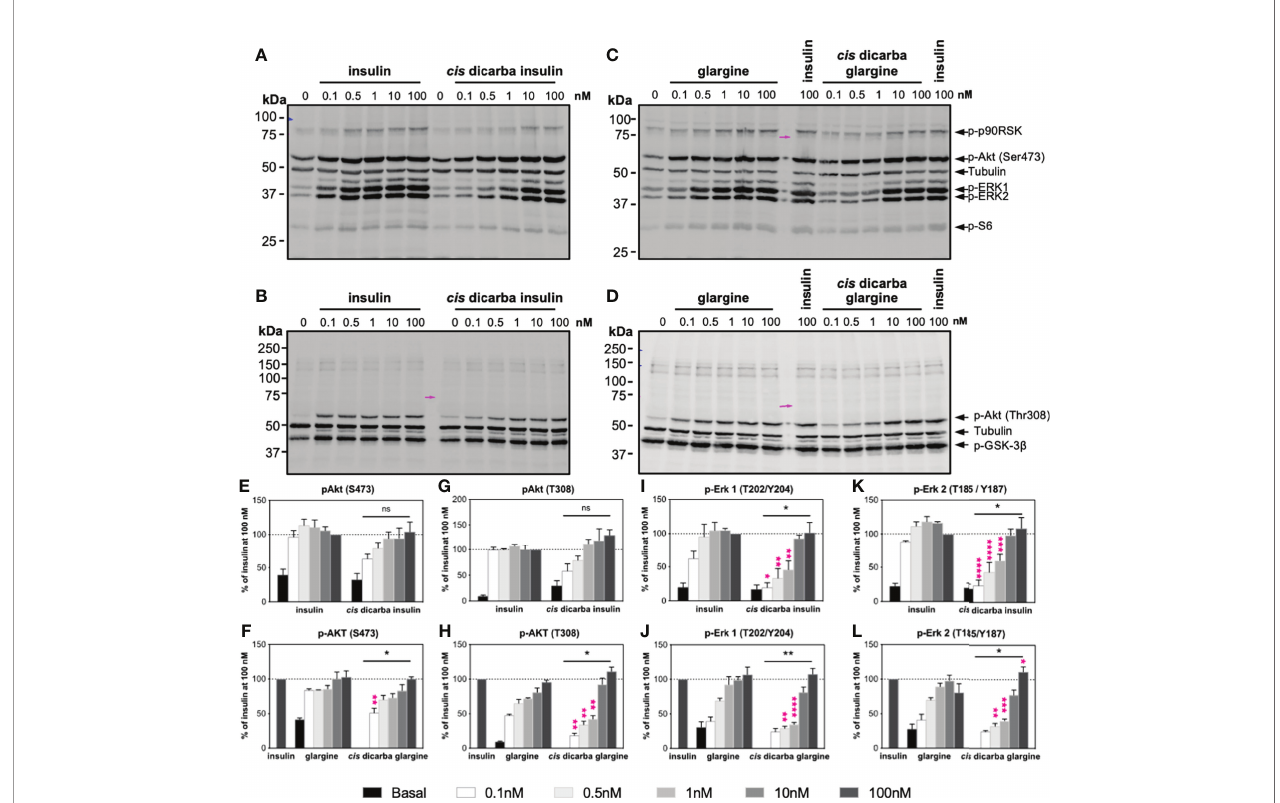
FIGURE 4 | Cis- dicarba insulin and cis- dicarba glargine insulin exhibit dose-dependent signaling bias via IR-A overexpressing cells. Serum starved IR-A overexpressing L6 myoblasts (hIR-A L6) were stimulated for 10 min with increasing concentrations (0, 0.1, 0.5 1, 10 and 100 nM) of (A – B) insulin or cis- dicarba insulin, (C, D) insulin glargine or cis- dicarba glargine. Pink arrow aligns to 75 kDa marker (representative blots of n = at least 3 independent experiments). (E-L) Quantitation of western blots. Phosphorylation levels are expressed as percentage of level detected when cells were stimulated with 100 nM of insulin for 10 min; normalized to b -tubulin: (E, F) Akt (phospho-Ser473), (G, H) Akt (phospho-Thr308), (I, J) ERK 1 (phospho-Thr202/Tyr204) and (K, L) ERK 2 (phospho-Thr185/ Tyr187). Quantitation of other phosphorylated proteins are included in Figure S3 . All data are the mean ± S.E.M . Statistical signi fi cance of the overall difference in phosphorylation levels stimulated by cis- dicarba insulin compared to native insulin or cis- dicarba glargine compared to glargine insulin were determined via 2 -way ANOVA (bars above graph); difference comparing each stimulating concentration (pink asterisks) were further analyzed using Holm-Sidak test. ns: non-signi fi cant; * (P ≤ 0.05), ** (P ≤ 0.01); *** (P ≤ 0.001); **** (P ≤ 0.0001). Dose-dependent signalling analyses were also performed in IR-B overexpressing cells (see Figures S4 – S5